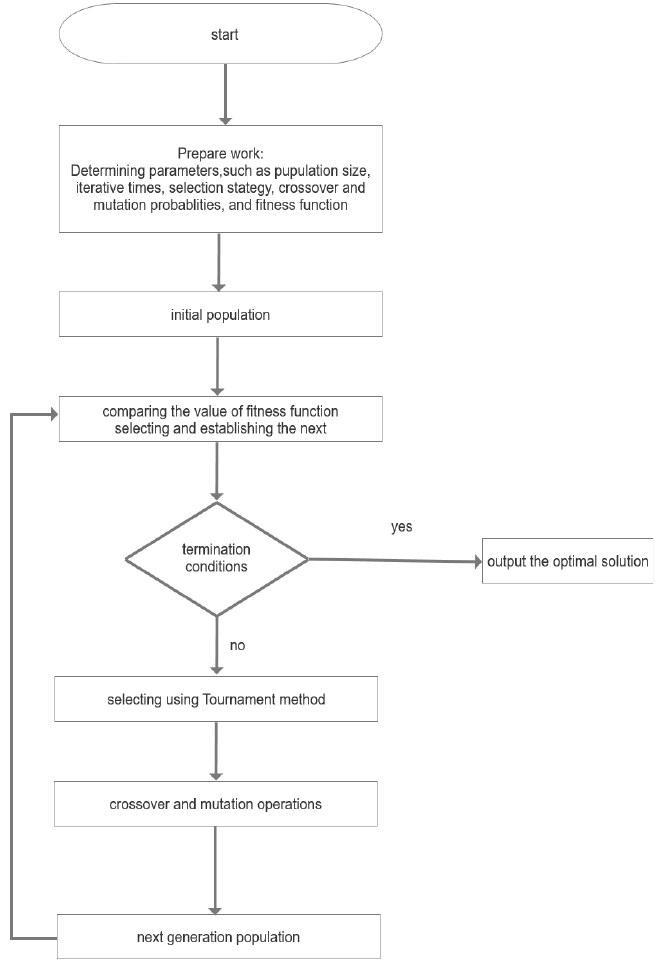
Figure 7. Flow chart of MRCGA algorithm.